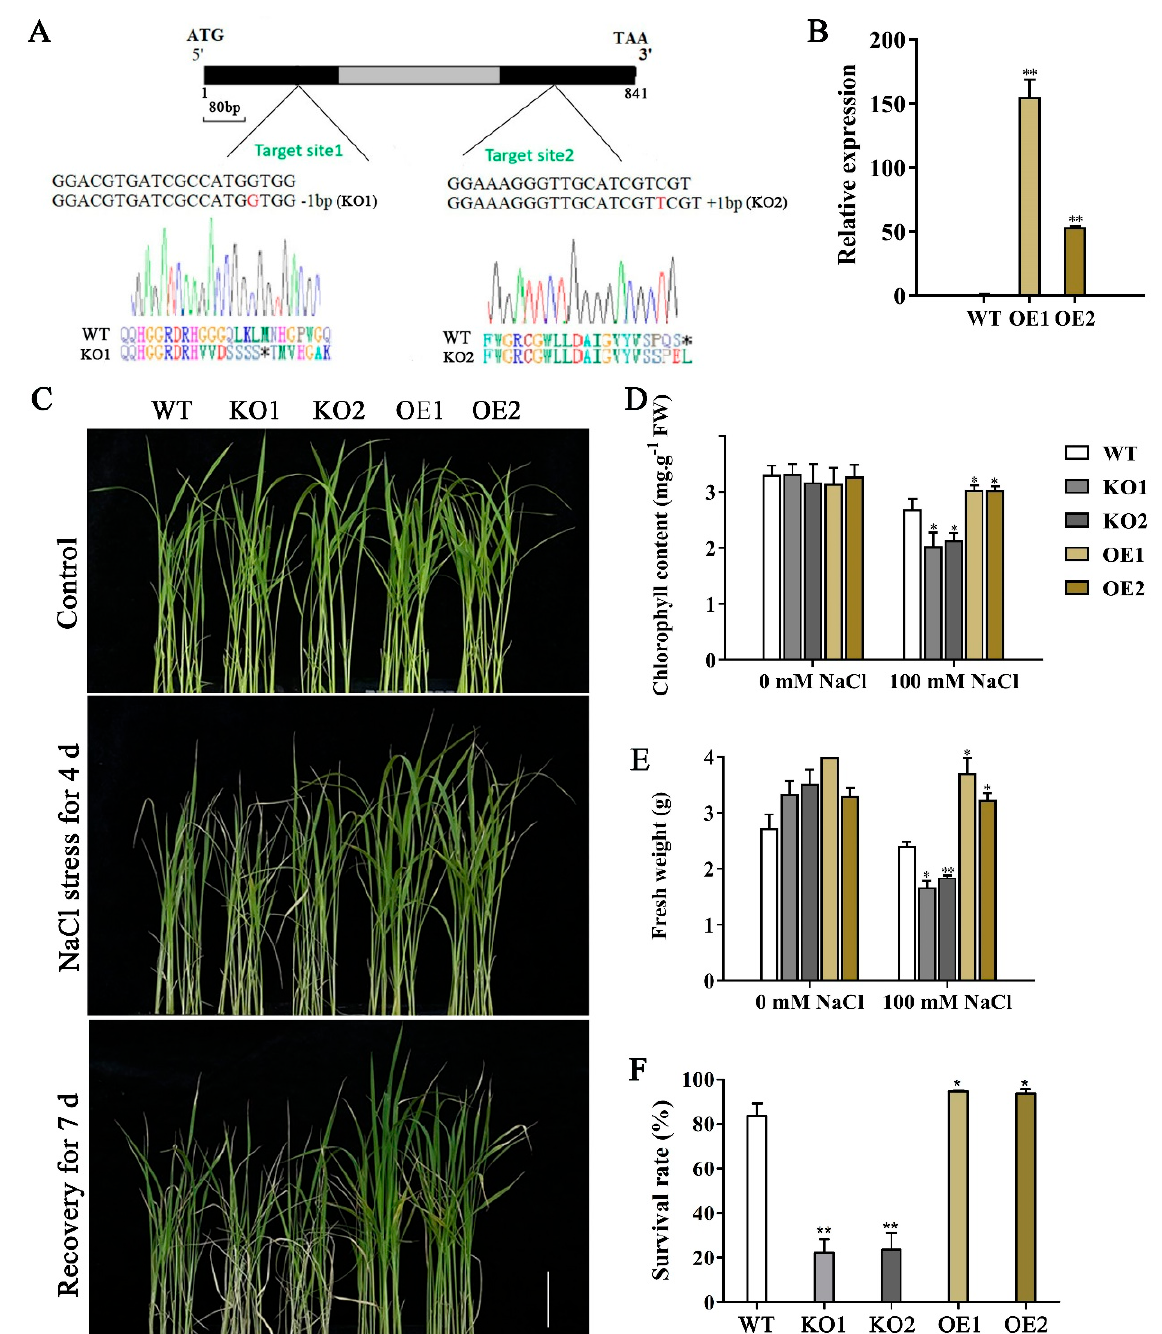
Figure 3. OsJRL40 confers salt stress tolerance in rice. ( A ) Schematic representation of the OsJRL40 CDS. Black and gray rectangles indicate exons and intron, respectively. The CRISPR/Cas9-targeted sites used for the generation of osjrl40 KO mutants are indicated. The 1-nt deletion and 1-nt insertion in OsJRL40 exons in KO1 and KO2 lines, respectively, are also shown. Premature stop codons in the deduced amino acid sequences of the mutant OsJRL40 proteins are indicated with asterisks. ( B ) Relative expression levels of OsJRL40 in WT, OE1, and OE2 leaves. ( C ) Phenotypic comparison of KO1, KO2, OE1, OE2, and WT seedlings treated with 100 mM NaCl at the three-leaf stage. ( D – F ) Chlorophyll content ( D ), fresh weight ( E ), and survival rate ( F ) of KO1, KO2, OE1, OE2, and WT seedlings treated with 100 mM NaCl. Data represent mean ± standard deviation (SD) of three independent replicates. Asterisks indicate statistically significant differences (Student’s t -test; * p < 0.05, ** p < 0.01).